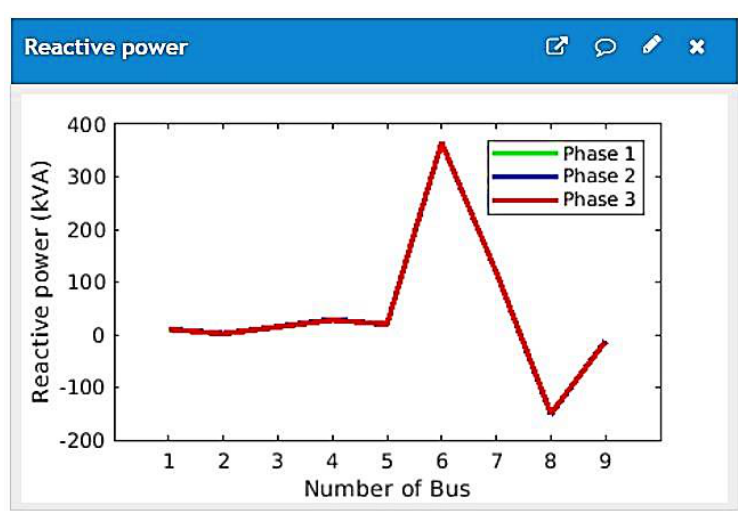
Figure 12. The graphical user interface of active power profile.